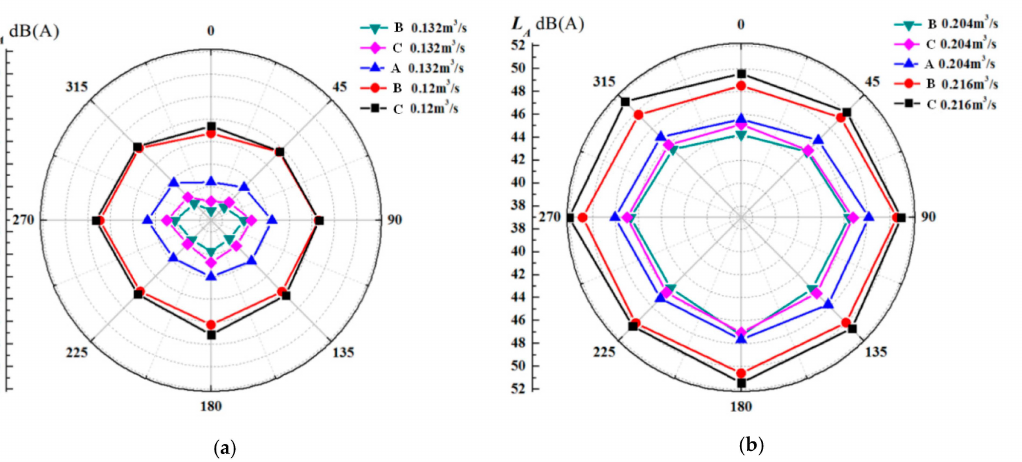
Figure 8. Comparison of outlet noise of different blade models (including two rotating speeds). ( a ) Outlet noise at the low flow, ( b ) outlet noise under high efficiency.